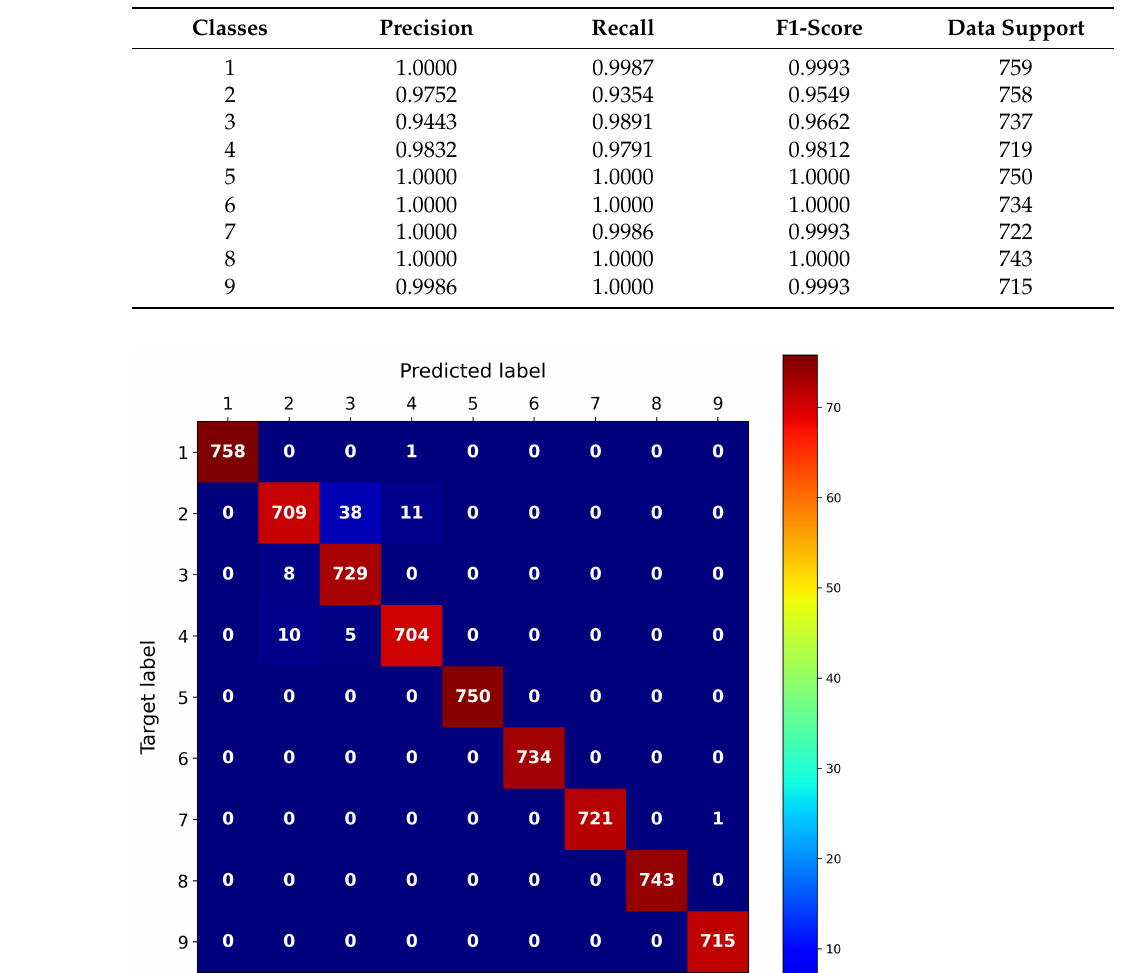
Table 2. Performance Metrics of CNN.